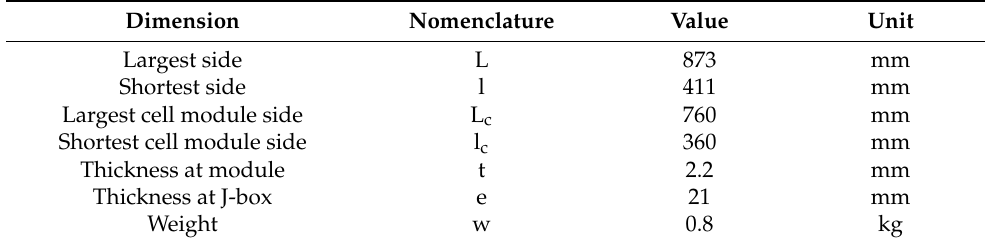
Table 2. Geometric specifications of flexible PV panels.